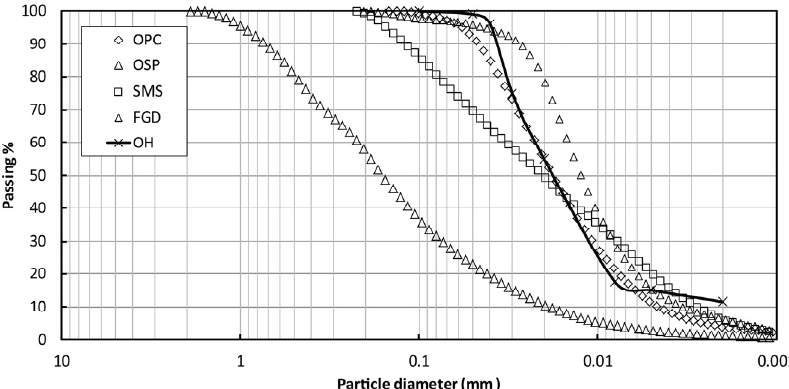
Figure 1. Particle size distribution of the different